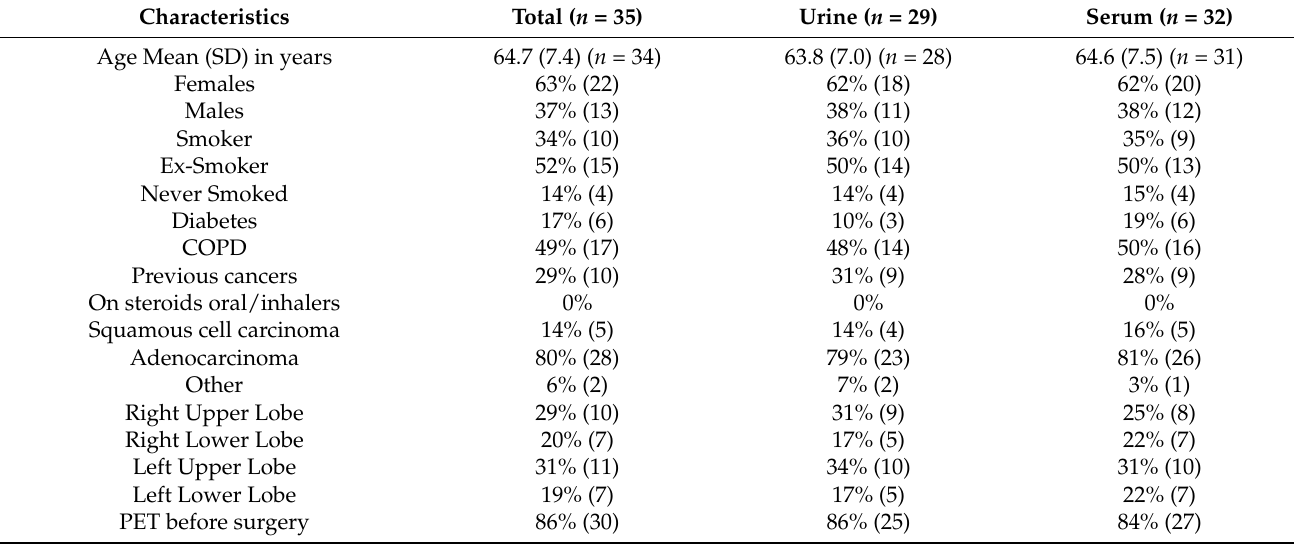
Figure 1. Patient enrollment and biofluid collection. Table 1. Clinical characteristics of the patient cohort.